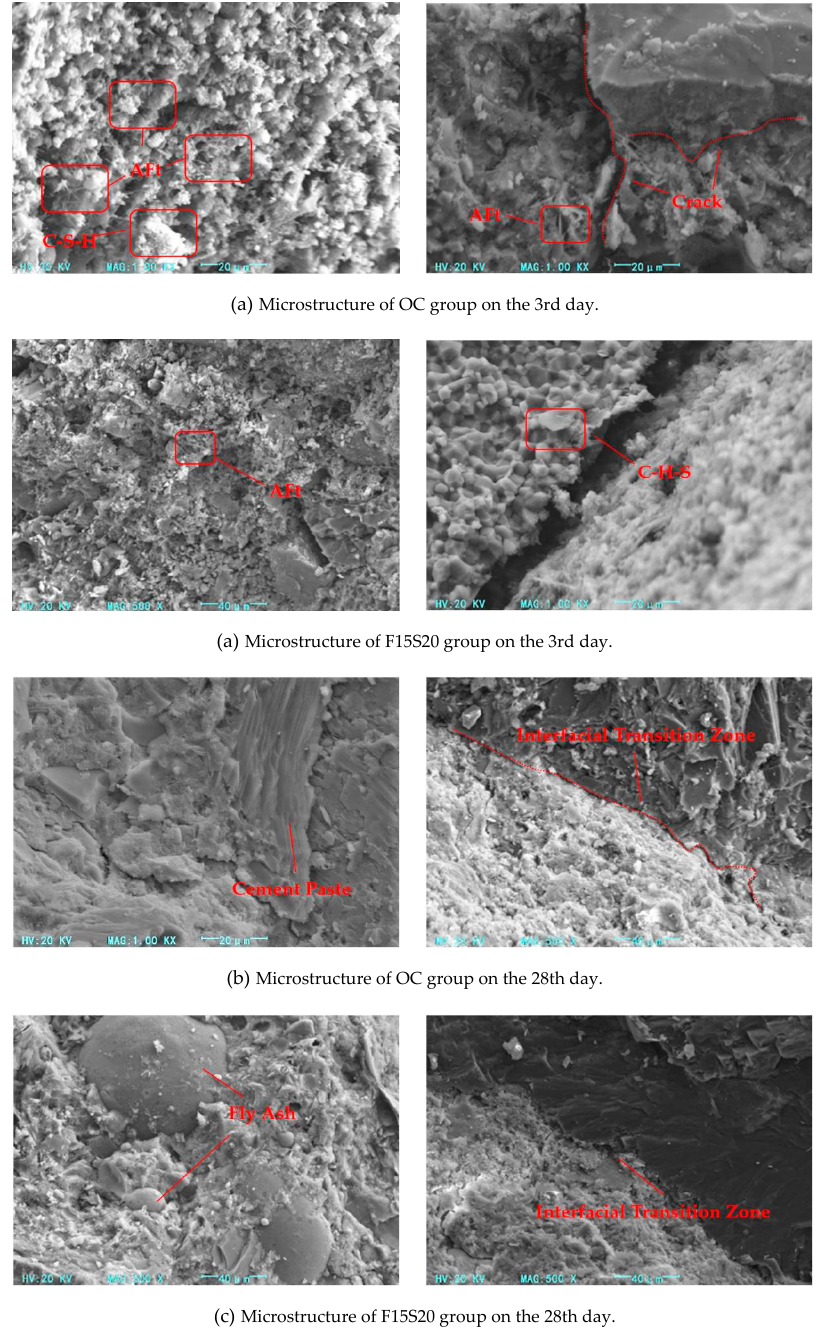
Figure 11. Microstructure of concrete at different ages: ( a ) microstructure of OC group on the 3rd